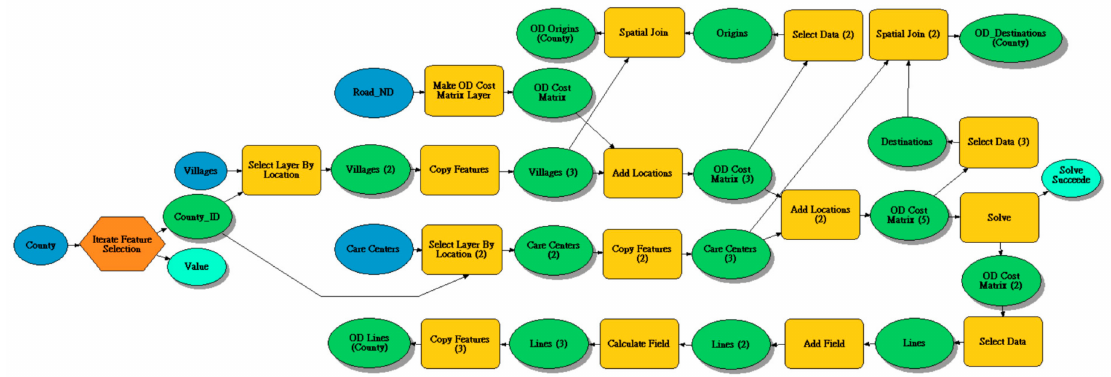
Figure 1. Domain partition OD (origin-destination) cost matrix calculation approach using the “Model Builder” programming of the ESRI